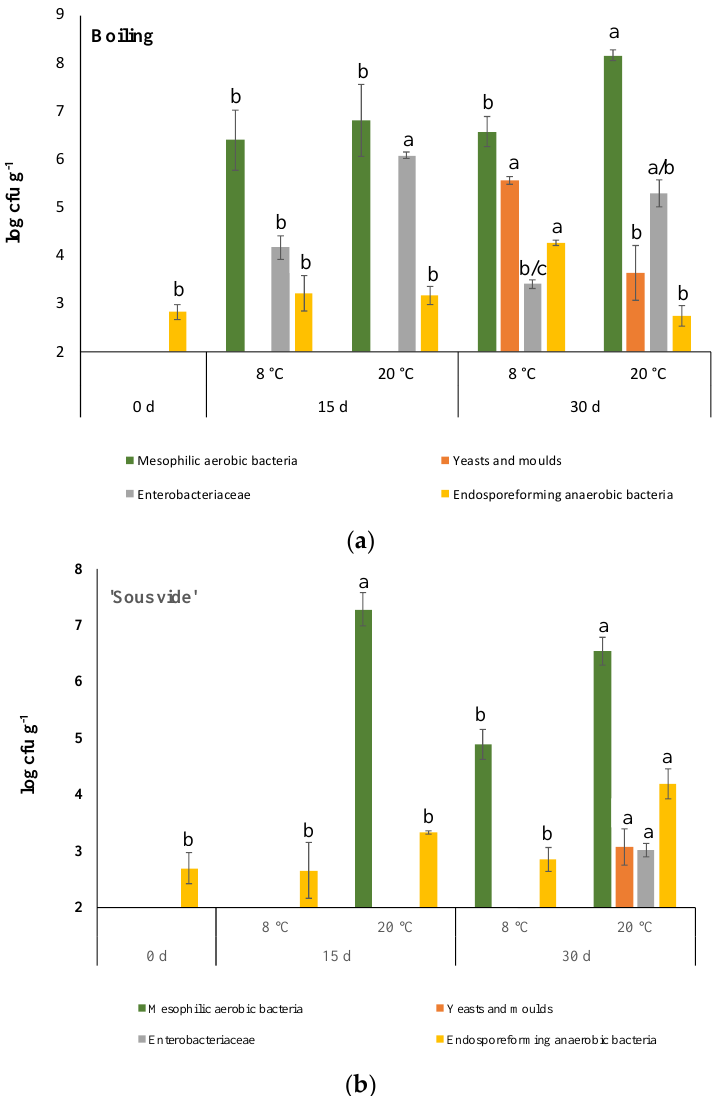
Figure 6. Comparison of viable cell densities of different microbial populations during 30 days of storage at 8 and 20 °C. Panel ( a ): boiled samples; panel ( b ): ‘sous vide’ samples. Limit of detection 2 log cfu g −1 FM. The lowercase letters for each microbial population during cold storage indicate statistical differences ( p < 0.05) after a one-way analysis of variance (ANOVA) followed by the post hoc Duncan test.